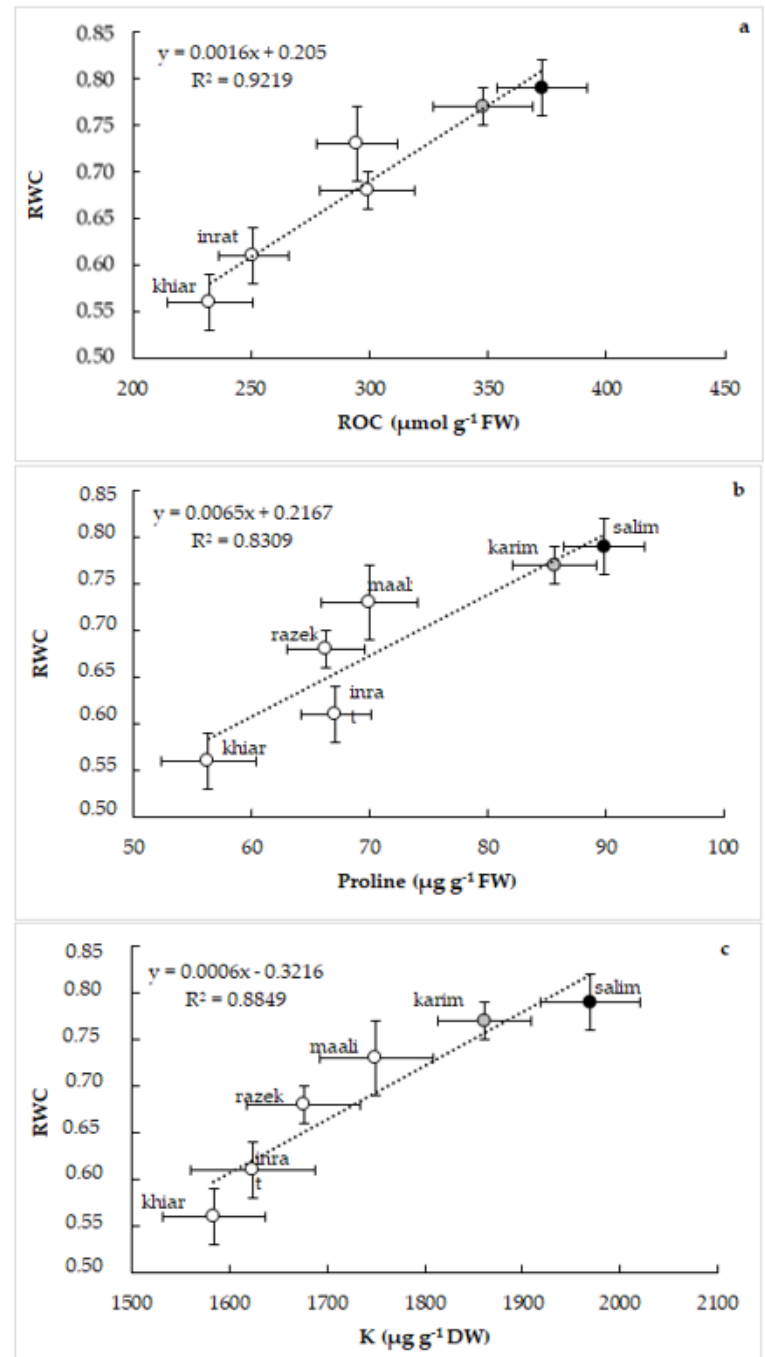
Figure 7. Relationships between relative water content (RWC) and relative osmolyte content (ROC, ( a )), between relative water content (RWC) and proline concentration ( b ), and between relative water content (RWC) and potassium (K) concentration in shoots ( c ) of durum wheat ( Triticum durum Desf.) subjected to drought stress. Vertical and horizontal standard errors of means of 10